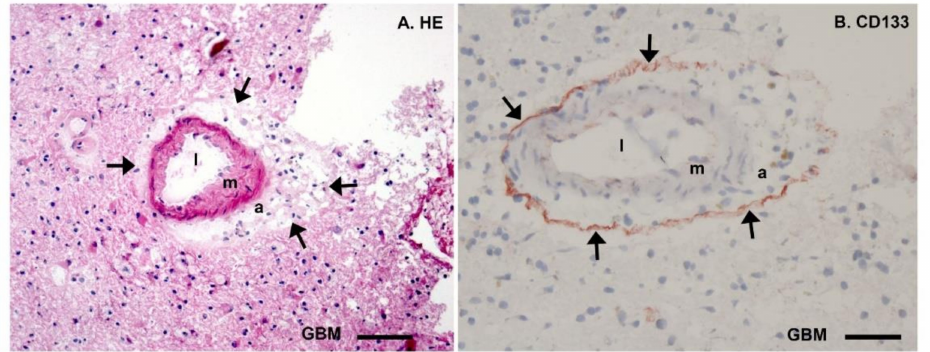
Figure 2. Microscopic images of cryostat sections (8 µ m thick) of patient glioblastoma tumor tissue stained with hematoxylin– eosin (HE, ( A )) and Giemsa combined with immunohistochemical detection of the stem cell biomarker CD133 (arrows, red) showing glioblastoma stem cells (GSCs) in their protective hypoxic peri-arteriolar niche ( B ). Both in ( A ) and ( B ), a cross section of an arteriole is shown with the lumen (l), the tunica media containing smooth muscle (m), the tunica adventitia containing stroma (a) and surrounded by a thin layer of GSCs adjacent to the tunica adventitia in ( B ) and then differentiated glioblastoma cells (GBM). Bars: ( A ), 100 µ m and ( B ), 50 µ m. Reprinted with permission